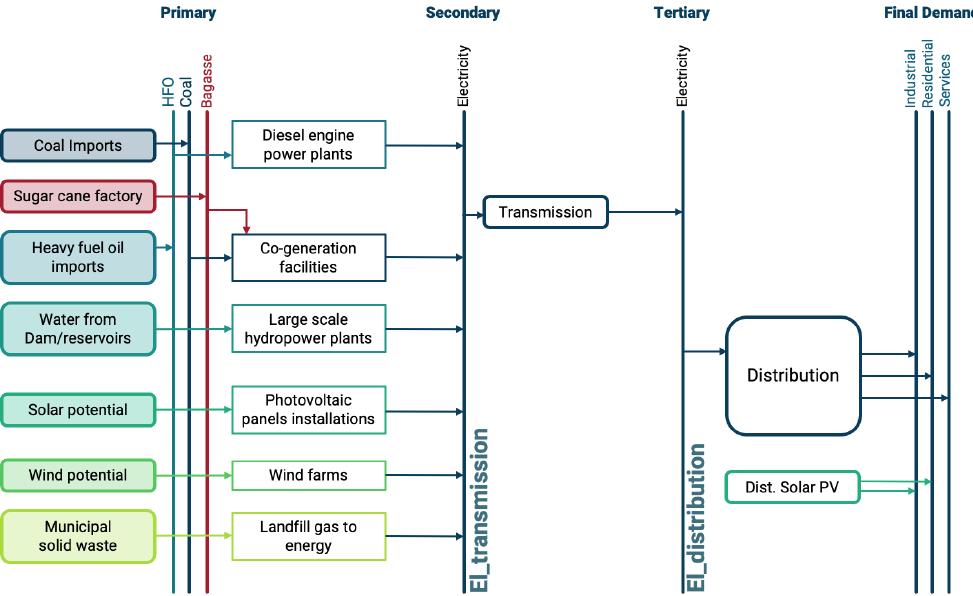
Figure 3. SARI reference energy system